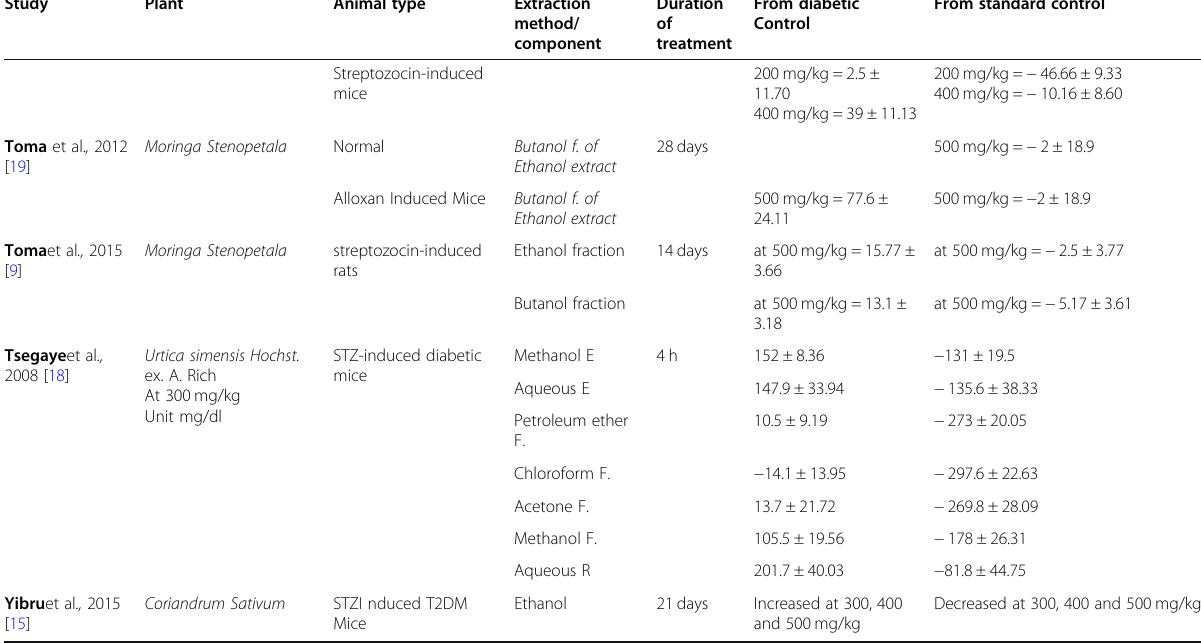
Table 3 In vivo anti-diabetic activity of medicinal plat in Ethiopia (Continued) Study